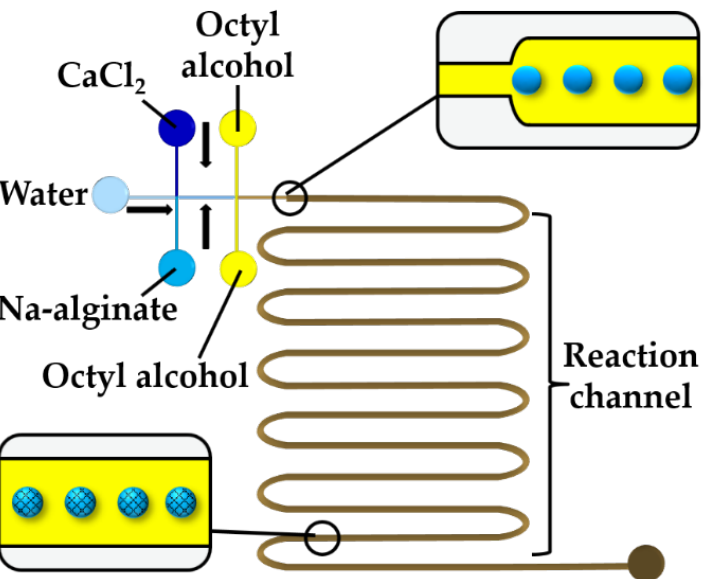
Figure 12. Formation of alginate beads through rapid mixing of three aqueous streams in the chip consisting of two cross junctions. The middle water stream prevents premature crosslinking [62].